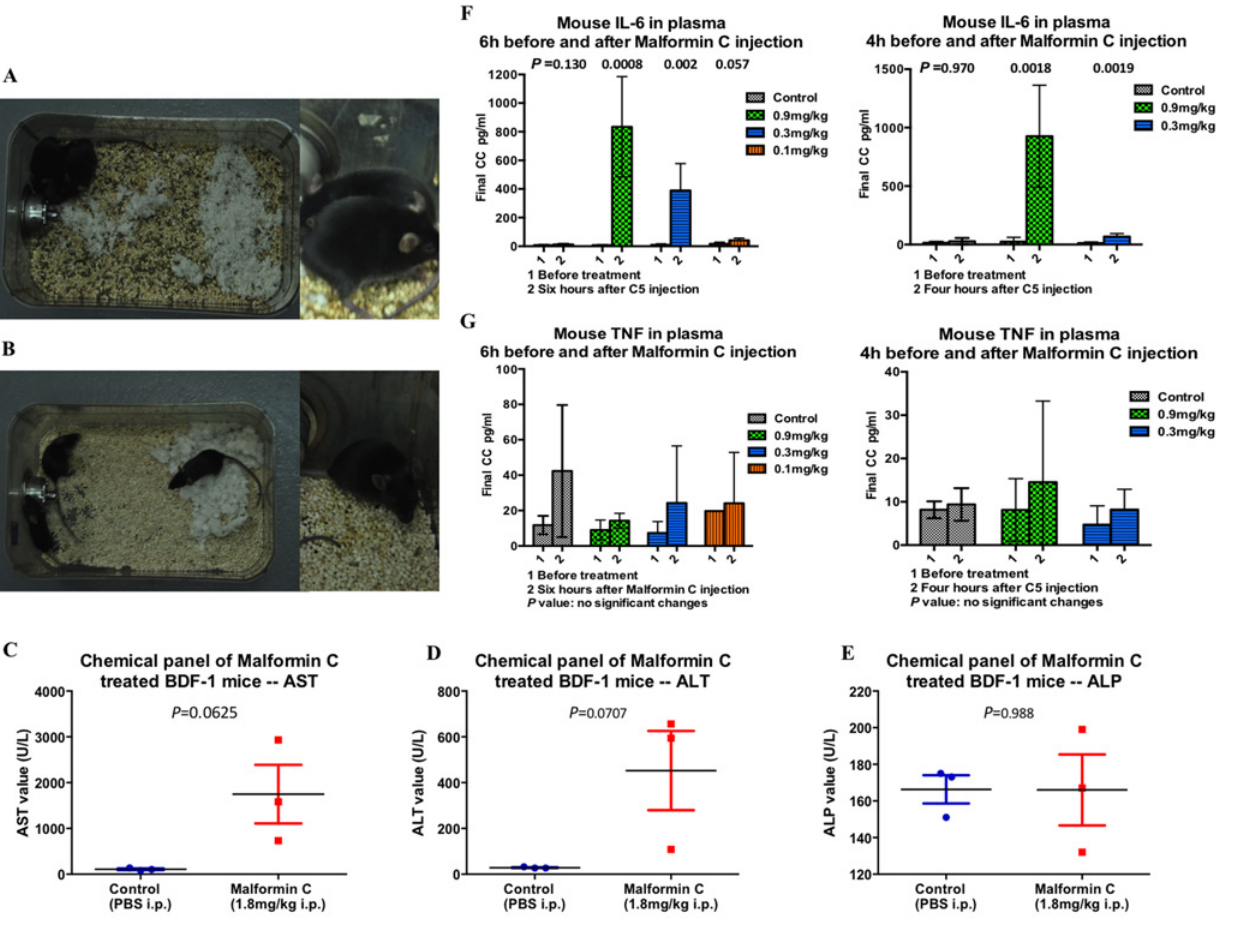
Fig 5. Pathological investigation of Malformin C treated mice. (A) Observation of mice prior to death injected with 1.8mg/kg Malformin C. The mice exhibited hunched posture, huddling and piloerection. (B) Control mice injected with PBS were active, with normal haircoats. (C) The parameter indicating the most different between treated and control mice was AST (aspartate aminotransferase). AST elevation may be lower than reported due to a hemolysis 3+, but is still abnormal. (D) There were also mild differences in ALT (alanine amino transferase) values between treated and control mice. (E) ALP (alkaline phosphatase) could be elevated with cholestasis, but in this case, the average value for the treated and control mice was identical, and thus not considered to be a significant finding. (F) Mouse IL-6 level in the plasma of Colon 38 bearing BDF-1 mice. The left graph showed a dose dependent increase of mouse IL-6 in the plasma 6 hours after 0.9mg/kg, 0.3mg/kg and 0.1mg/kg Malformin C injection compared to PBS group, while the right graph showed similar effects 4 hours after 0.9mg/kg, 0.3mg/kg Malformin C injection. (G) Mouse TNF level in the plasma of Colon 38 bearing BDF-1 mice. No significant changes were shown either 6 hours or 4 hours before and after different concentrations of Malformin C injection compared to PBS injection